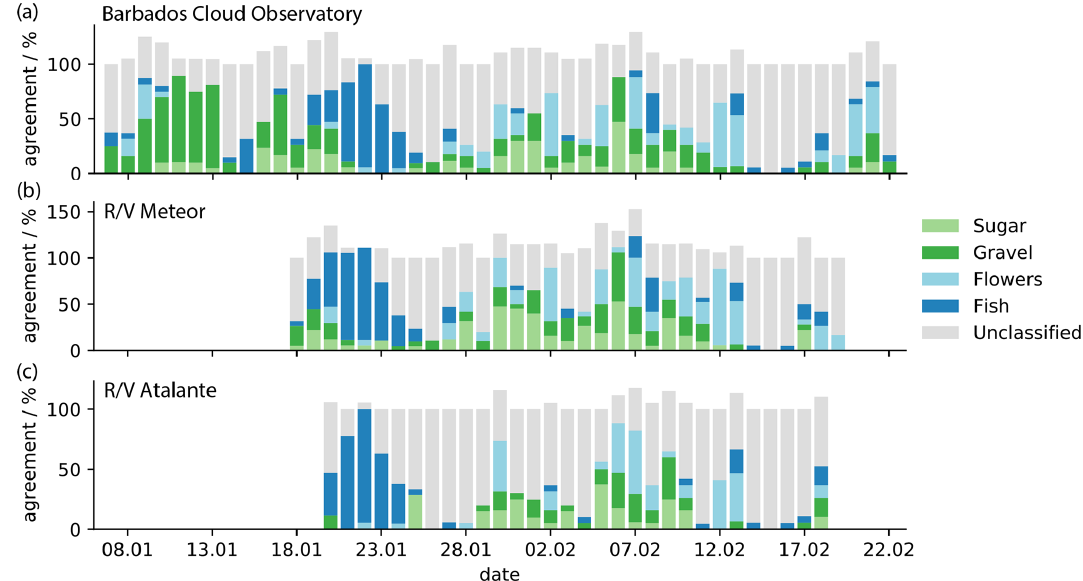
Figure 5. Exemplary use case of level 3 data: mesoscale setting of research platforms during EUREC 4 A based on the EUREC 4 A IR workflow ( a–c : Barbados Cloud Observatory (BCO), R/V Meteor and R/V Atalante ). Please note that the date format in this figure is